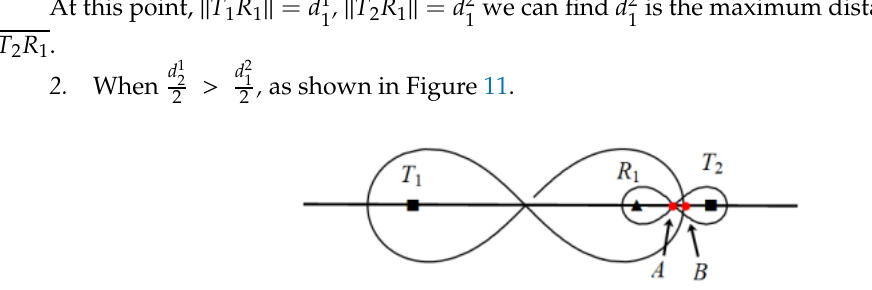
n T R T   1 2 d d  when . 2 1 > d 2 . n T R T  2 1